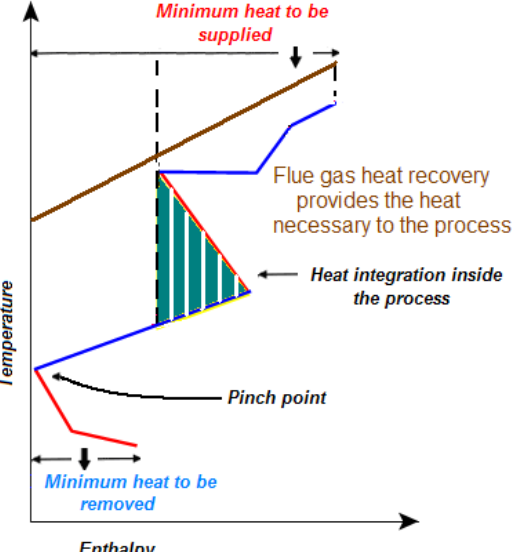
Figure 5. Recovery of flue gas enthalpy